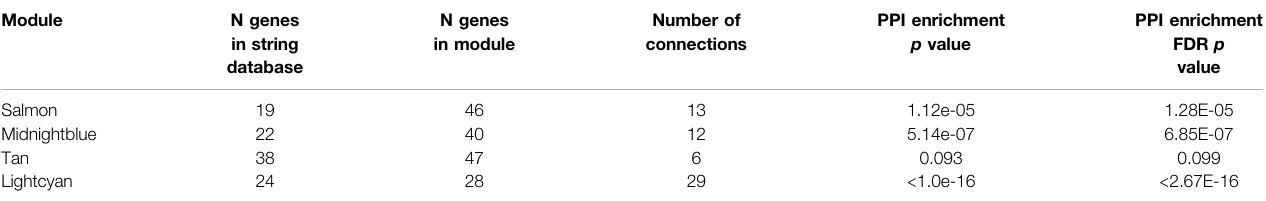
TABLE 3 | Protein-protein interaction enrichment of genes in non-preserved modules identi fi ed in the STRING database. FDR correction for 16 modules tested (grey unclassi fi ed module excluded).